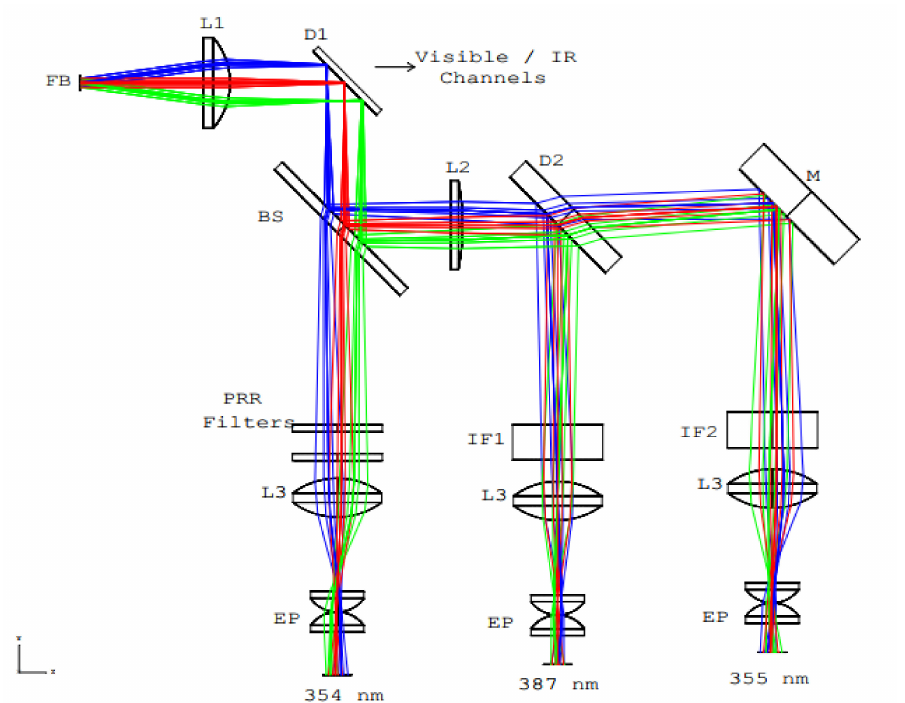
Figure 2. Zemax optical layout. FB stands for fiber bundle, L for lens, D for dichroic mirror, BS for beam splitter, EP for eyepiece, IF for interferential filter and M for mirror. Blue/red/green rays have a divergence of 15 ◦ , 0 ◦ and − 15 ◦ . 15 ◦ corresponds to the numerical aperture of the fiber bundle. Using a first dichroic beam splitter (D1) UV and Visible-IR branches of the collected backscattered radiation are divided. After the first reflection on D1, the UV portion of the spectrum is divided into three channels. The first 50/50 beam splitter (BS) divides the incoming light into equal portions. Lens L2 corrects the divergence of the rays for the channels at 354.76 and 386.7 nm (N 2 VRR spectra center wavelength). D2